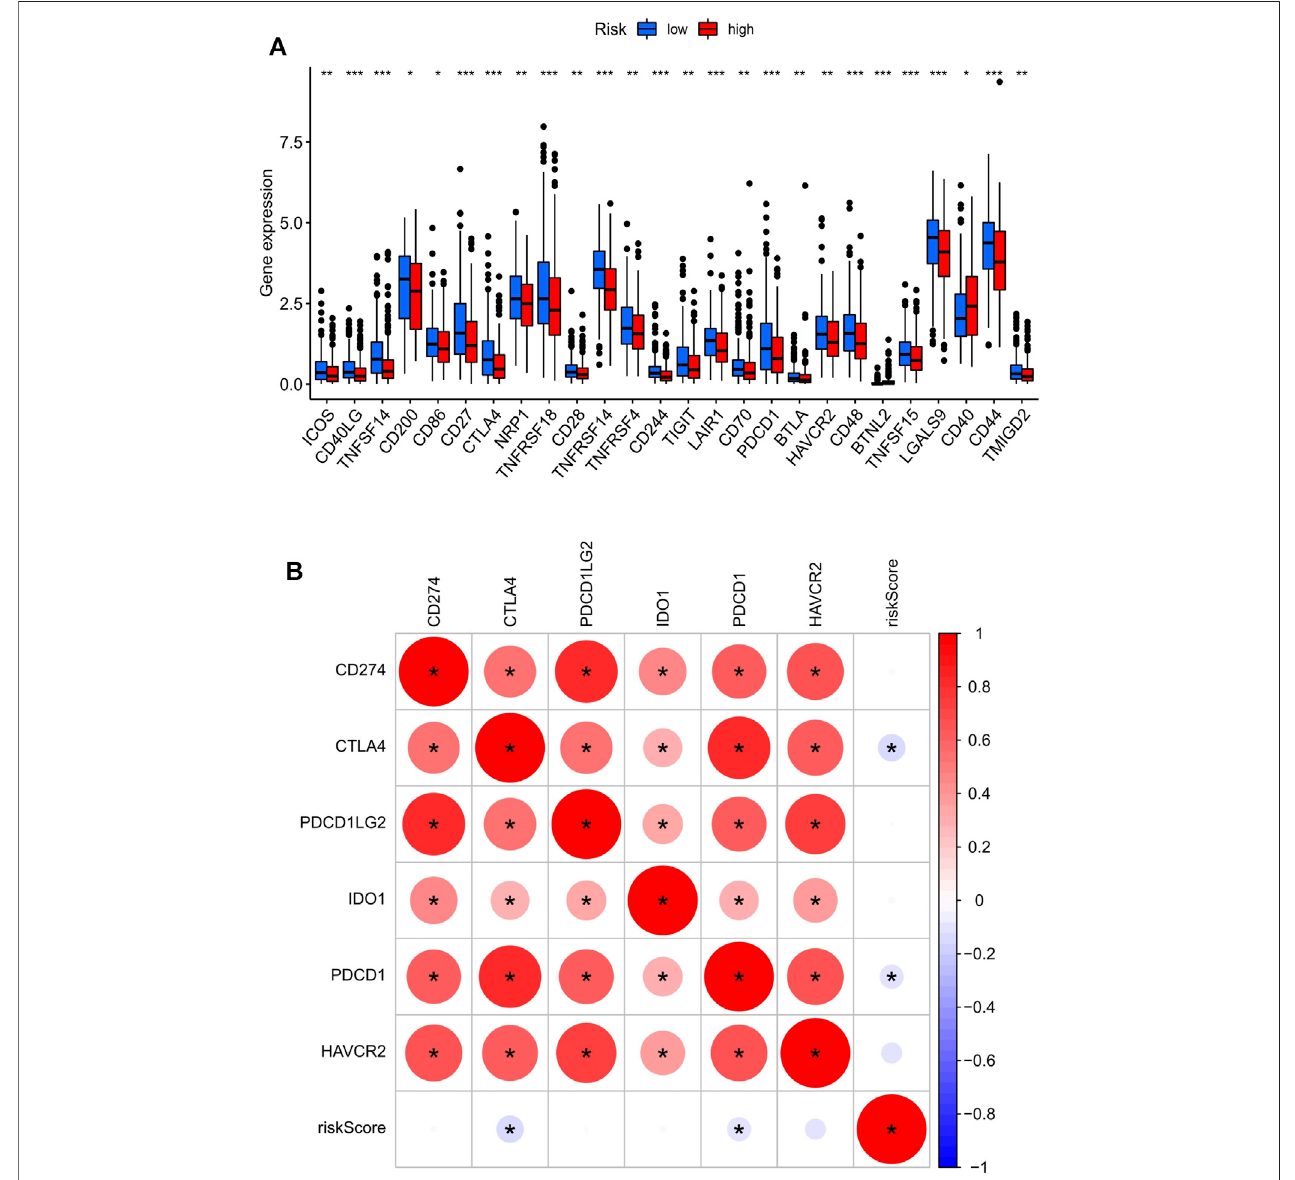
FIGURE 5 | The key immune checkpoint genes are related to the risk score in the UCEC tumor-immune microenvironment. (A) The landscape of 26 types of immune checkpoint genes in low- and high-risk score groups. *** p < 0.001, ** p < 0.01, * p < 0.05. (B) The correlation between the risk score and the six most important checkpointgenes(CD274,PDCD1,PDCD1LG2,CTLA4,HAVCR2,andIDO1).Thebottomandtopoftheboxesarethe25thand75thpercentiles(interquartilerange).*: statistically signi fi cant; red: positive correlation, blue: negative